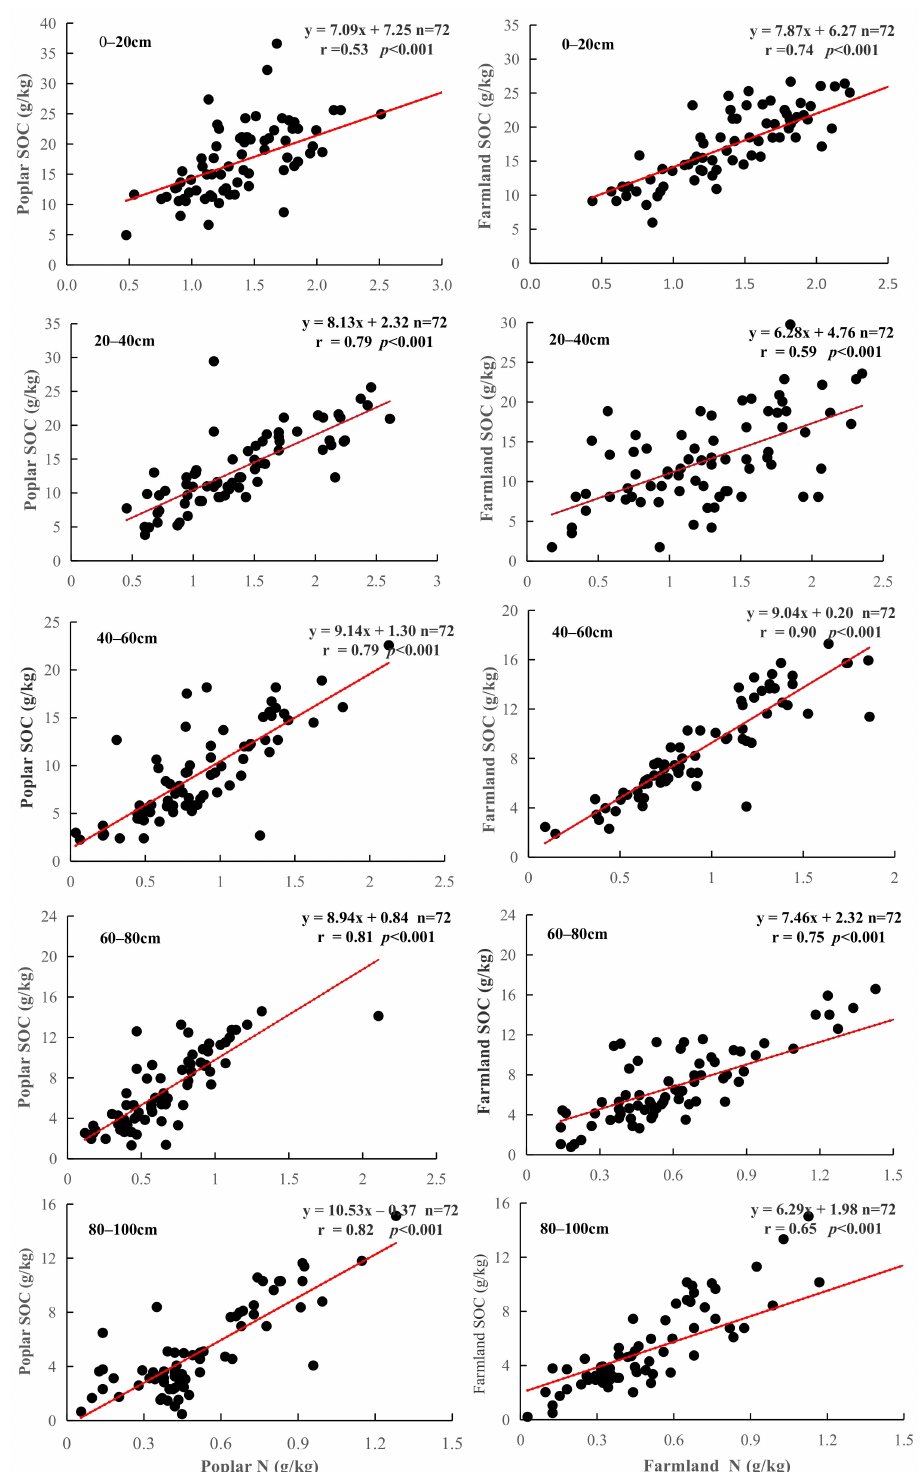
Figure 3. Differences in the correlations between soil total N concentration and SOC concentration in poplar and farmland at different soil depths. Left: poplar shelterbelts. Right: farmlands. From the top raw to the lowest raw of the figures are 0–20 cm, 20–40 cm, 40–60 cm, 60–80 cm, and 80–100 cm soil layer, respectively. The slopes for total N-SOC in poplar in deep soils >20 cm were 1.29, 1.01, 1.19, and 1.67-fold higher than those in farmland, while in 0–20 cm, farmland had 1.11-fold higher slope value than the poplar